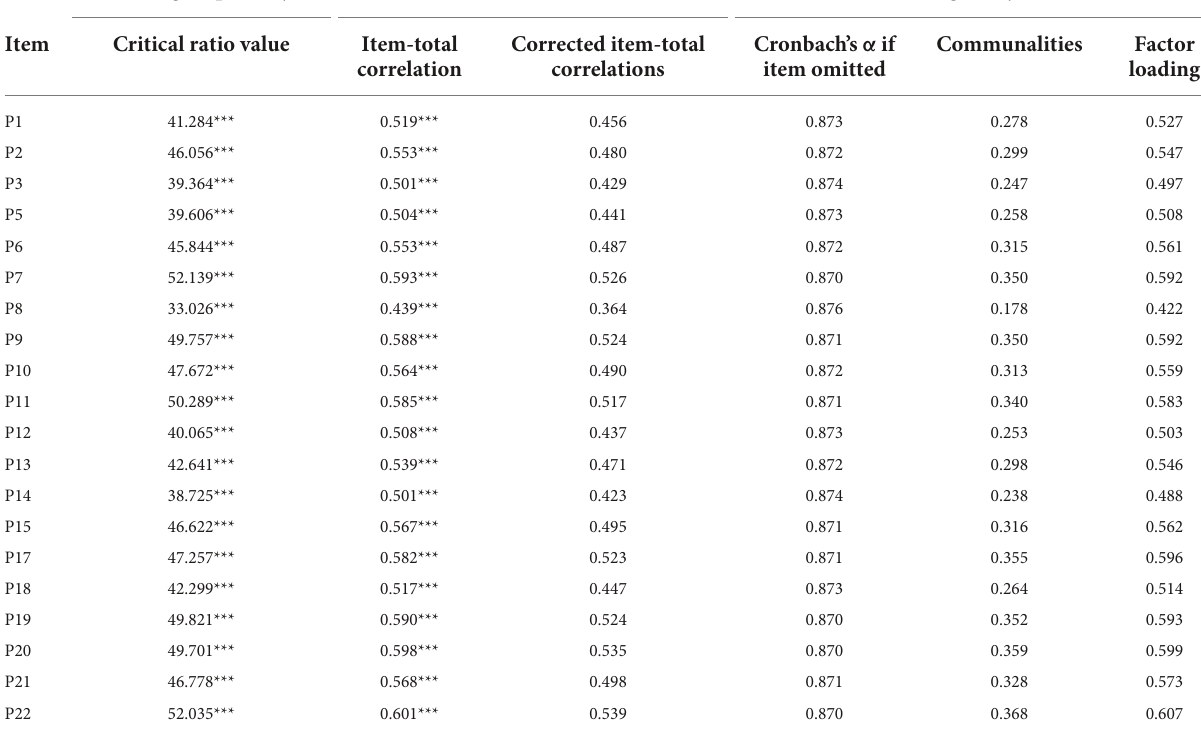
TABLE 3 Results of the item analysis.